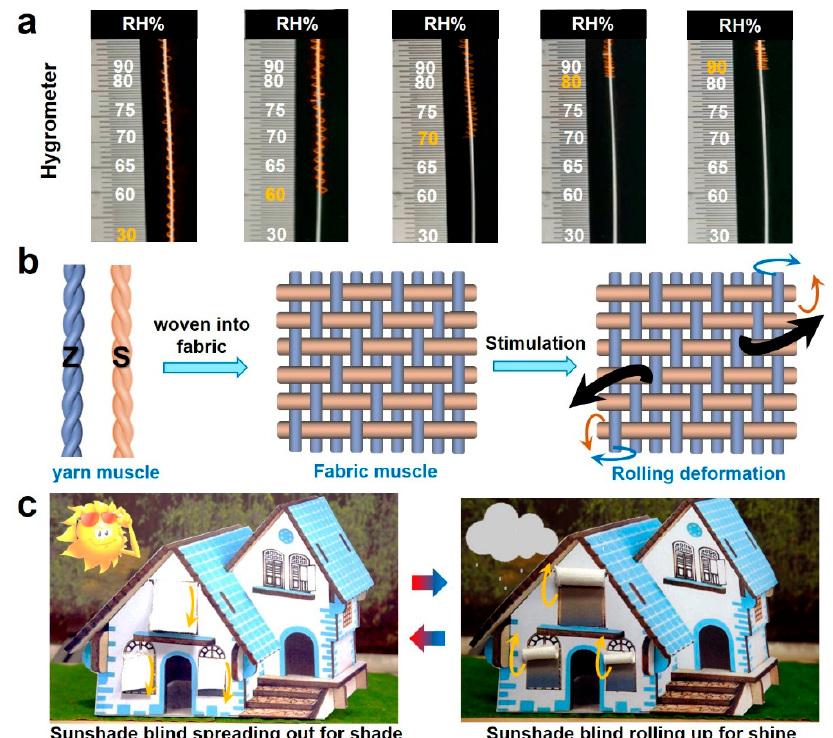
Figure 4. Potential applications and scalable fabrication of fiber-based artificial muscles. ( a ) Natural hygrometer made of coiled yarn muscles. ( b ) Scalable fabrication of twisted yarn muscles into fabric muscles. ( c ) An example of fabric muscle’s application in smart sunshade blind.